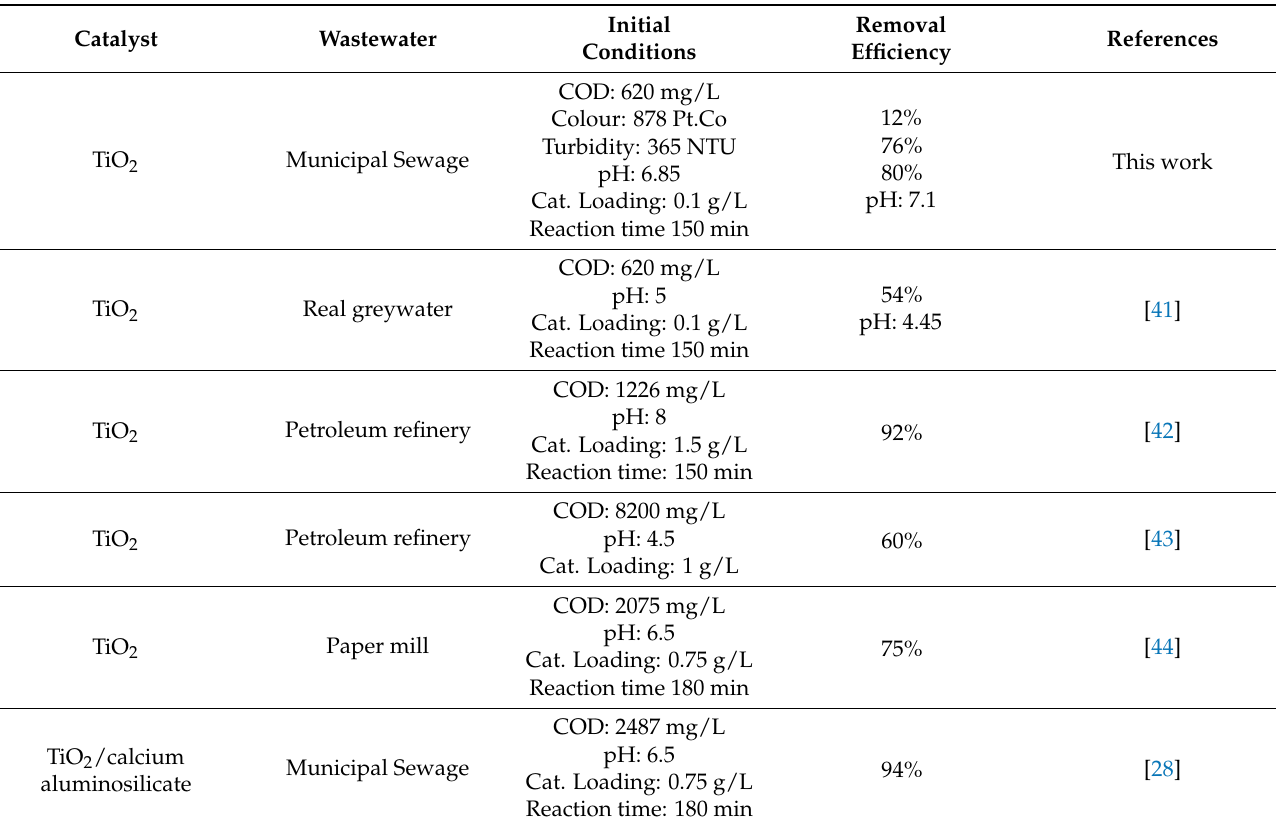
Table 2. Comparative studies on TiO 2 photo-catalytic degradation of actual